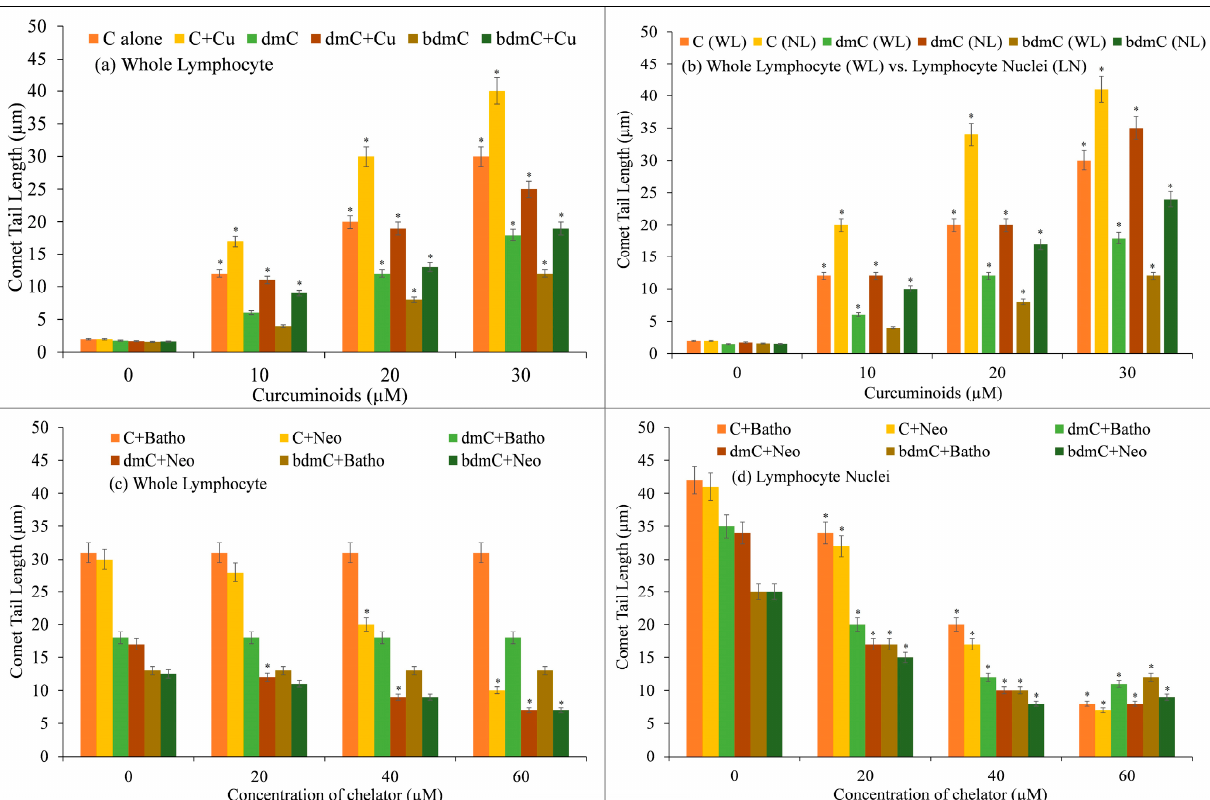
Figure 2. DNA cleavage in human peripheral lymphocytes by C, dmC, and bdmC. ( a ) Lymphocyte cells were treated in microfuge tubes with a reaction mixture for one hour at 4 degrees Celsius in the dark. The reaction mixture consisted of RPMI (400 μ L); Ca 2+ ‐ and Mg 2+ ‐ free PBS; and increasing concentrations of C, dmC, and bdmC (0–30 μ M), alone and with a fixed concentration of Cu(II) (25 μ M), and was further processed for comet assay. ( b ) Comparison of DNA cleavage by C, dmC, and bdmC in whole lymphocytes and lymphocyte nuclei using the comet test. Whole lymphocyte cells/lymphocyte nuclei imbedded in agarose were treated for 1 h at 4 °C with the reaction mixture comprising the appropriate concentrations of C, dmC, and bdmC (0–30 μ M) and then subjected to comet assay. Whole lymphocytes ( c ) and lymphocyte nuclei ( d ) embedded in agarose were incu ‐ bated with the reaction mixture (2.0 mL) containing C, dmC, and bdmC (30 μ M) and the indicated concentrations of membrane permeable copper chelator (Neo) or membrane impermeable copper chelator (Batho) at 4 °C for 1 h and then subjected to comet assay. The presented values are the mean ± S.E.M. of three separate experiments. The error bars represent ±S.E.M. * p < 0.05 compared to un ‐ treated control cells.